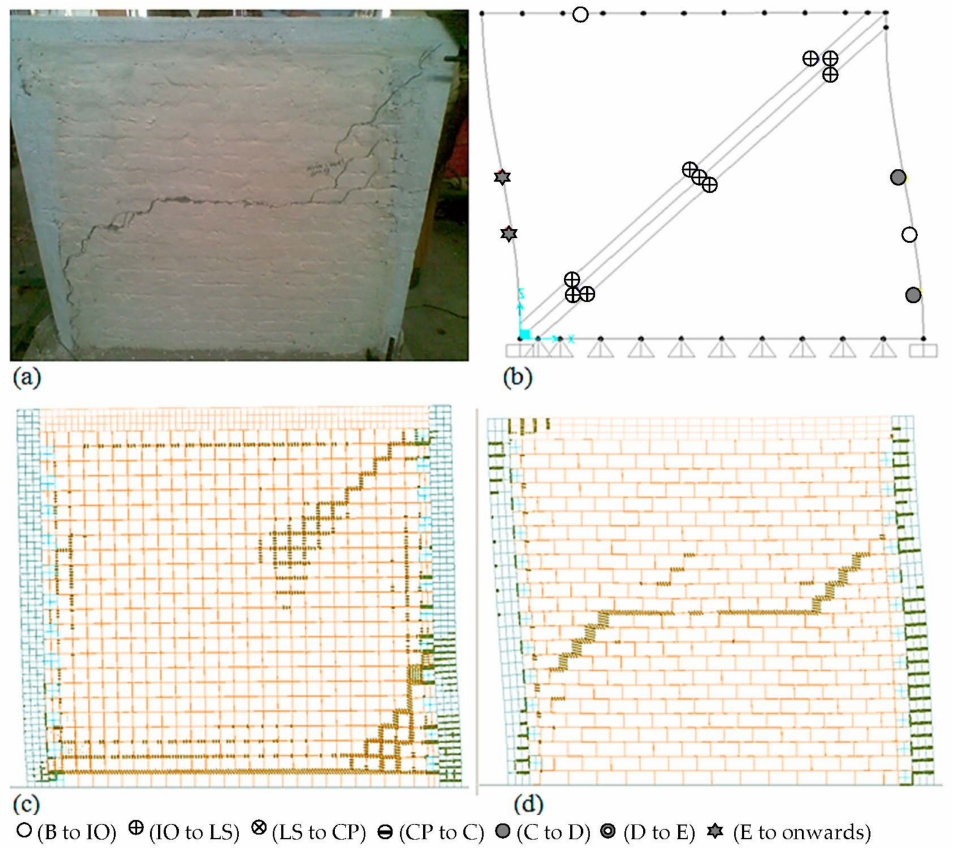
Figure 18. Comparison of CM damage profiles for ( a ) physical test (Waqar Ahmad, 2013); ( b ) tri-Strut model; ( c ) AEM; ( d ) AEM with cold